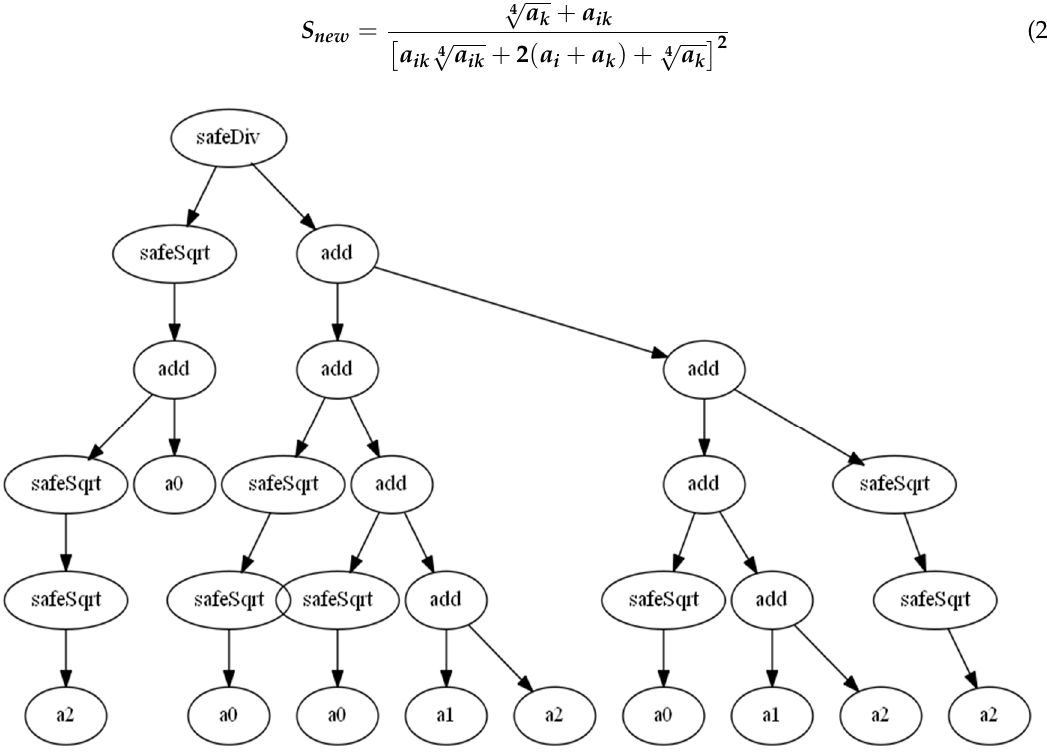
Figure 4. Best solution obtained by the GP approach, a 0 = a ik , a 1 =a i , and a 2 =a k .